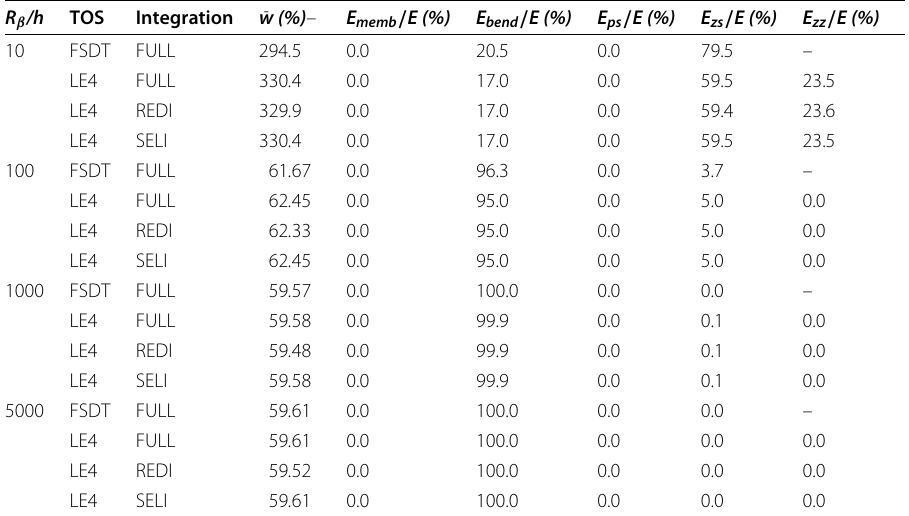
Table 2 Displacement and energy evaluation of the three-layered cylindrical panel under bending, obtained through hierarchical elements with p = 7 R β /h TOS Integration ¯ w (%) – E memb / E (%) E bend / E